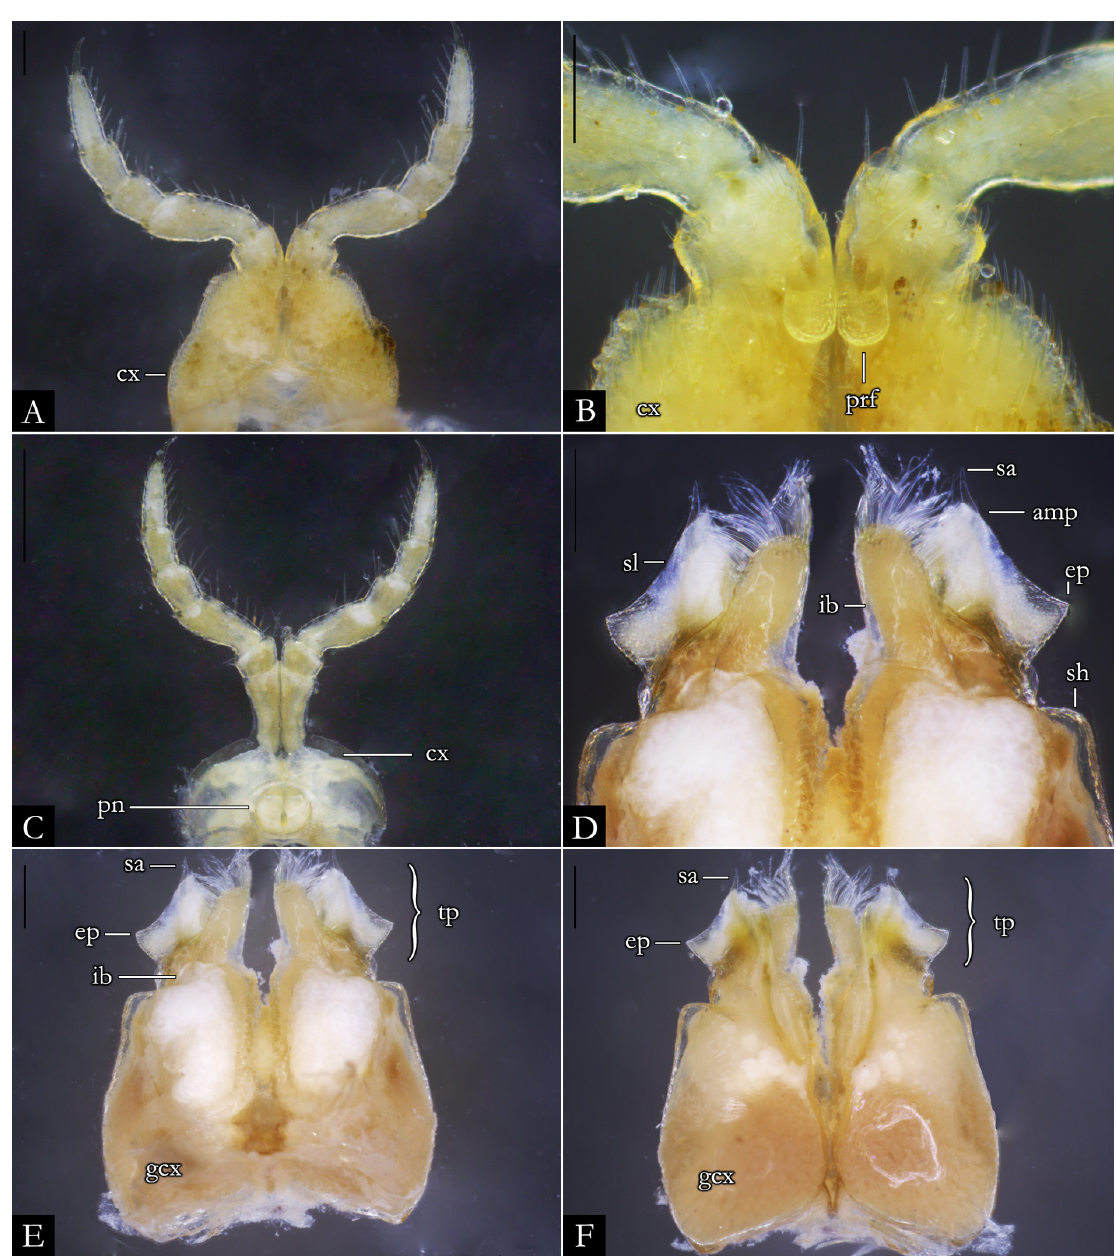
Fig. 144. Pseudonannolene xavieri Iniesta & Ferreira, 2014, ♂ (MNRJ 30148). A . First leg-pair. B . Detail of prefemur. C . Second leg-pair. D . Detail of telopodites, in anal view. E . Gonopods, in anal view. F . Gonopods, in oral view. Abbreviations: see Material and methods. Scale bars = 0.2